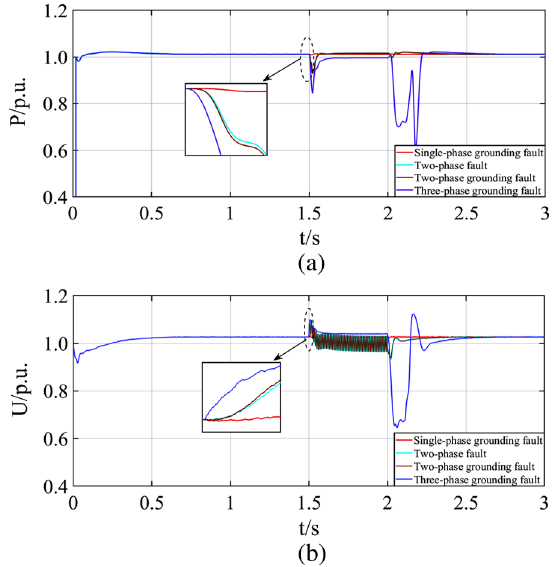
Fig. 13 Response curves of system under short circuit faults a comparison of active powers into power grid under different faults, b comparison of voltages at PCC under different faults